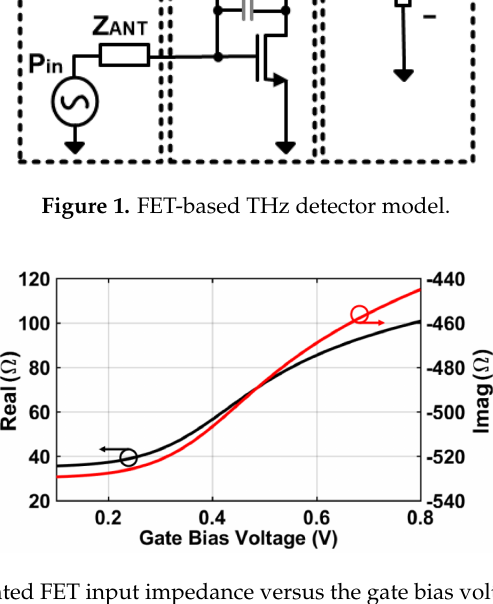
Figure 2. Simulated FET input impedance versus the gate bias voltage at 325